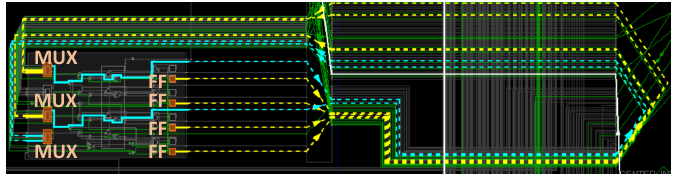
Figure 12. Place and route for one stage of 1-bit FF-APUF design [29] in the proposed MMPUF design.